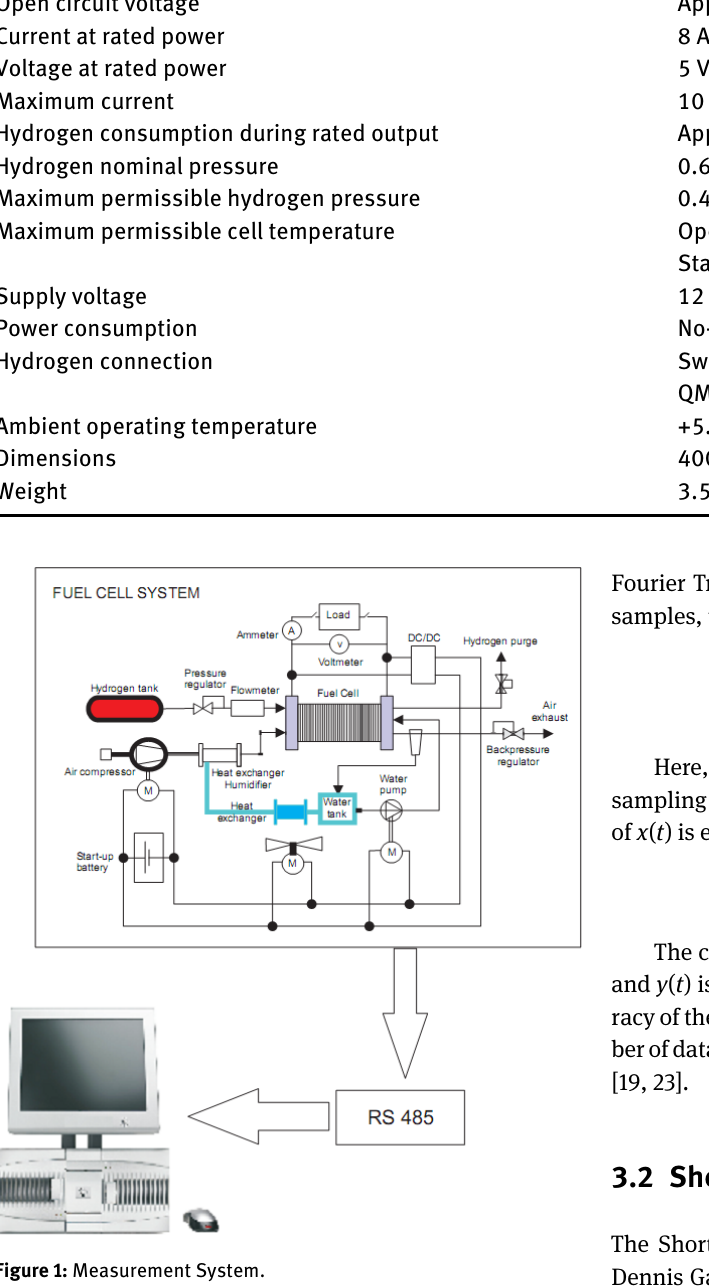
Figure 1: Measurement